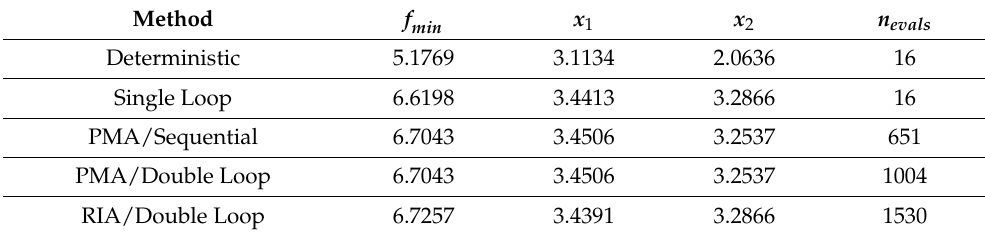
Table 1. Performance comparison of different optimization methods.